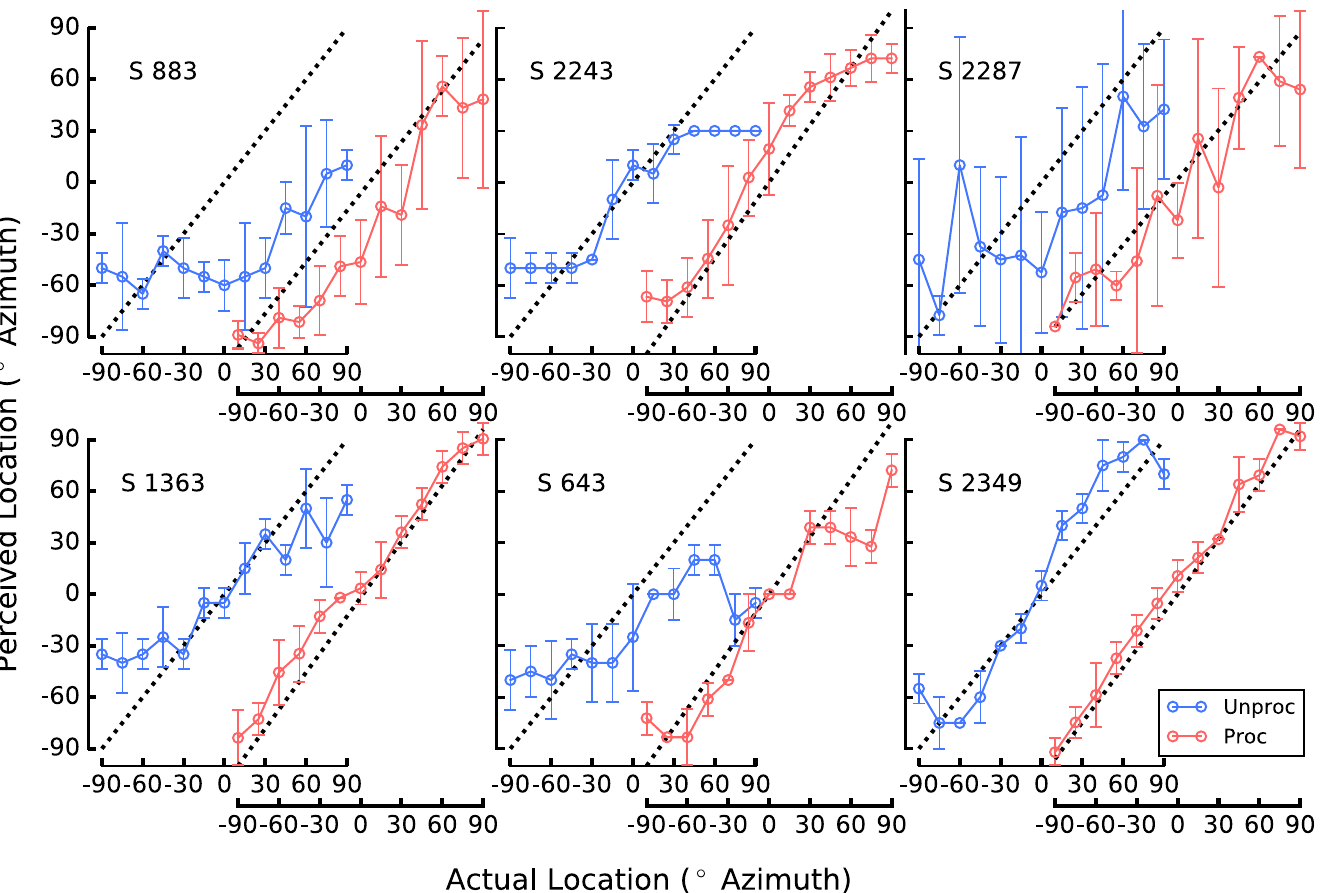
Fig 7. Localization performance for each participant. Each of the six participants are each represented in a separate panel. The blue open circles represent performance in the Unprocessed condition, the red open circles represent performance in the Processed condition, and error bars represent standard deviations. The X axes are staggered within each panel to facilitate comparison and to conserve